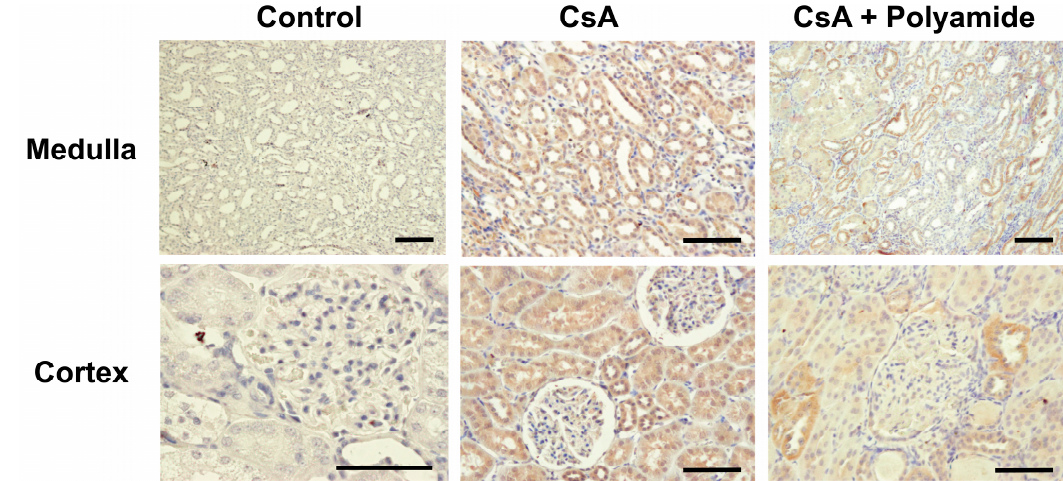
Figure 4. The effects of pyrrole-imidazole polyamide targeting human TGF- β 1 (Polyamide) on the expression of TGF- β 1 in CsA-induced nephropathy in marmosets. Male marmosets were housed and fed with a 0.05% NaCl and 0.05% magnesium diet and subcutaneously injected with CsA (40 mg / kg / day) for eight weeks. Marmosets with CsA-nephropathy were intravenously injected with Polyamide (1 mg / kg / week) for four weeks from four weeks after the start of CsA injection. Sections (thickness: 4 µ m) were incubated with TGF- β 1 anti-human TGF- β 1 antibody and then with horseradish peroxidase-conjugated anti-biotin labeling solution.